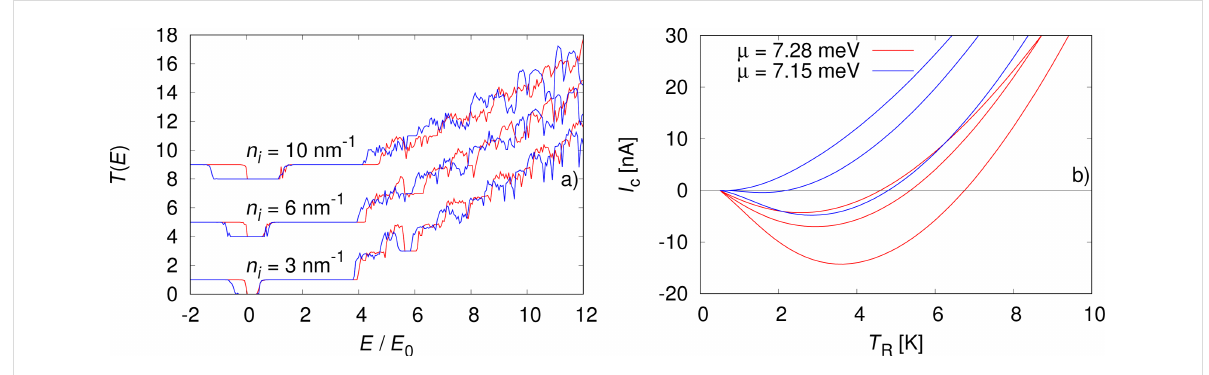
Figure 3: a) Transmission function and b) thermoelectric current calculated in the presence of impurities at B = 4.0 T. The nanowire length is L = 1000 nm and the impurity densities are n i =3.0 nm − 1 , 6.0 nm − 1 and 12 nm − 1 . The red curves are for scalar impurities with chemical potential μ = 7.28 meV and the blue curves are for magnetic impurities with μ = 7.15